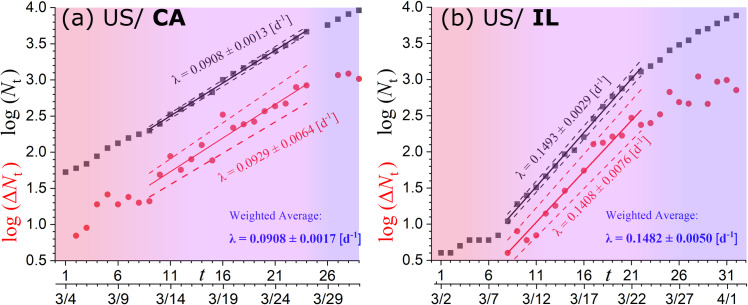
Linear fitting of the number of the total Nt and new ΔNt infected cases with time (on linear-log scale) for the states of California and Illinois, where the slope reads the exponential rate λ.The resulted rates from the linear fitting of log (Nt) (black) and log (ΔNt) (red) are (weighted) averaged (blue). The phases are color-coded as in Fig 1.